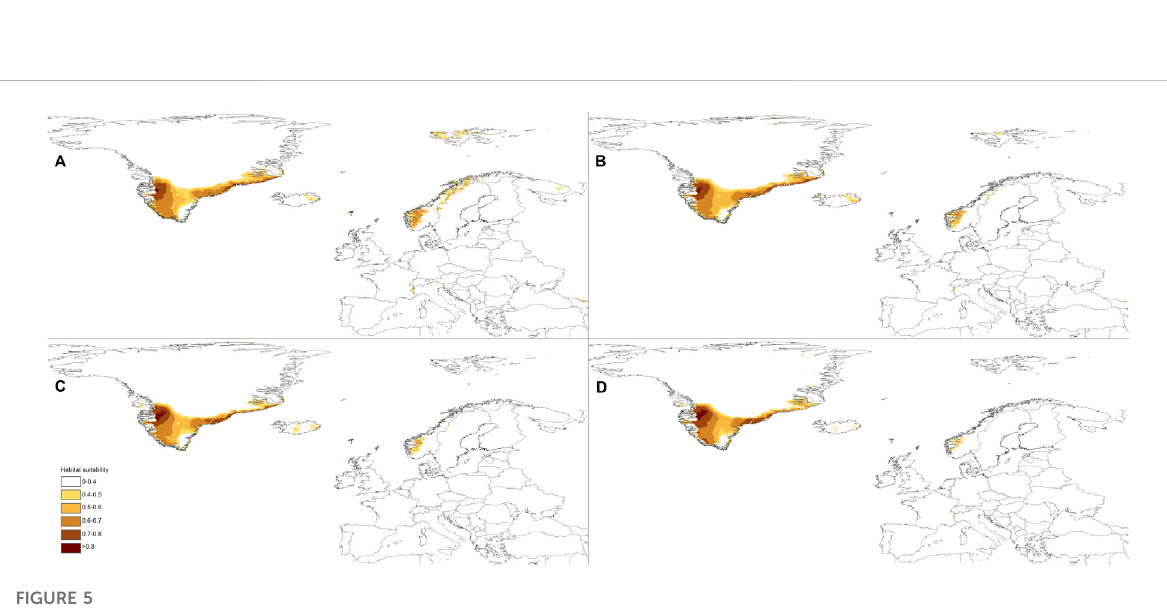
Frontiers in Environmental